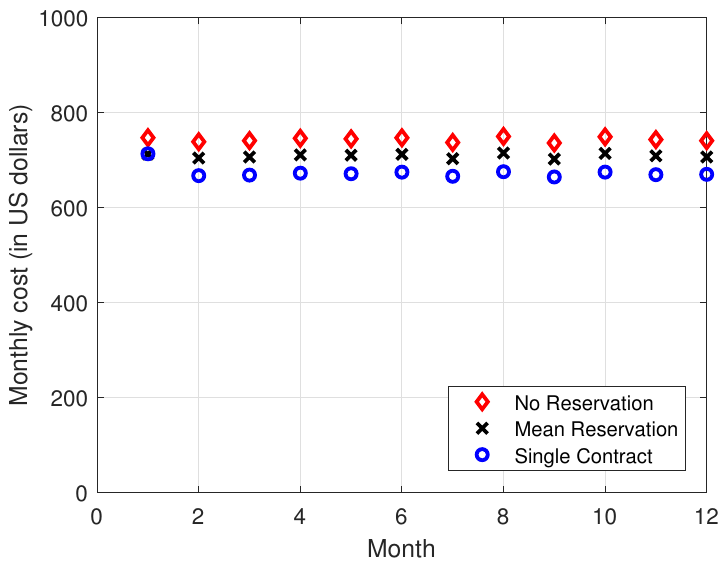
Figure 8. Monthly cost vs. month. The demand traffic is modeled as a Poisson stochastic process with mean = 4000 VMs. Monthly cost (in USD).